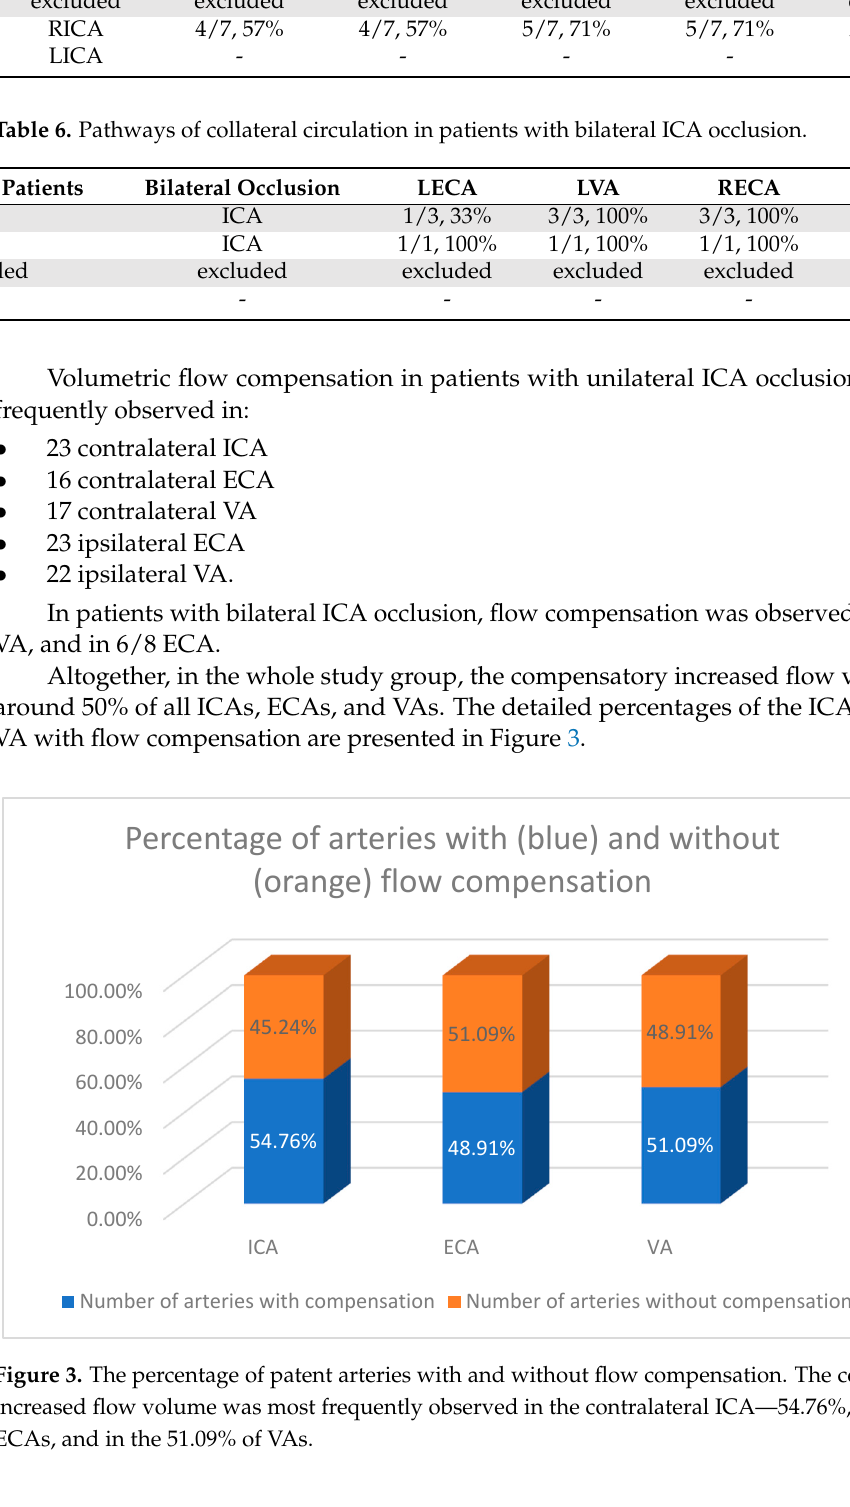
Table 5. Pathways of collateral circulation in patients with unilateral ICA occlusion.